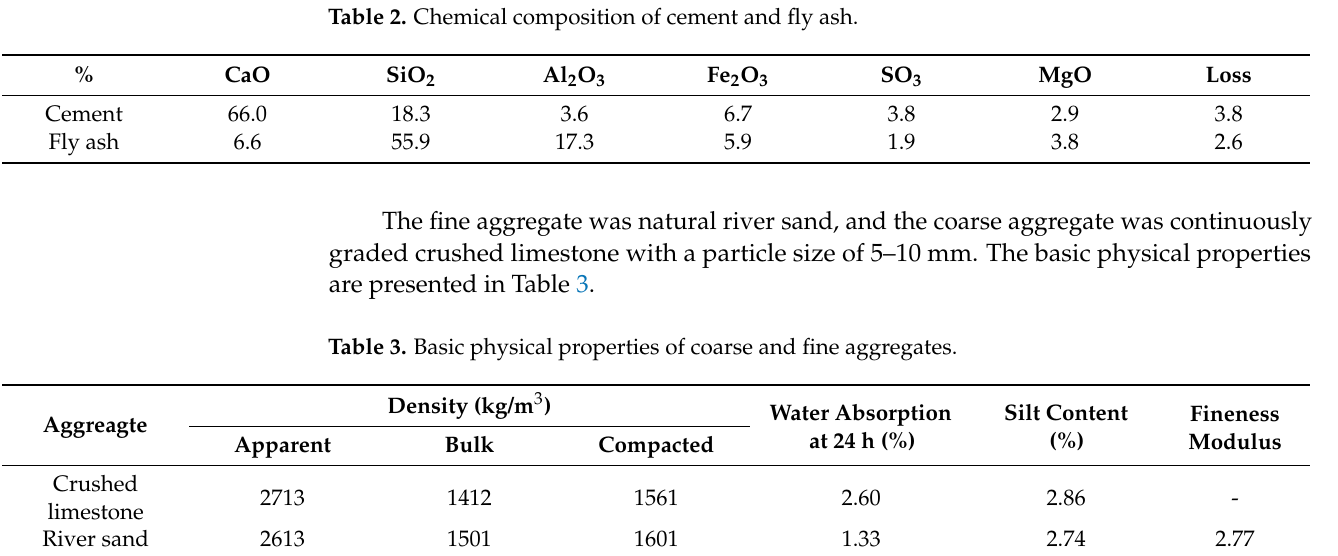
Table 1. Basic physical properties of cement. Table 2. Chemical composition of cement and fly ash.